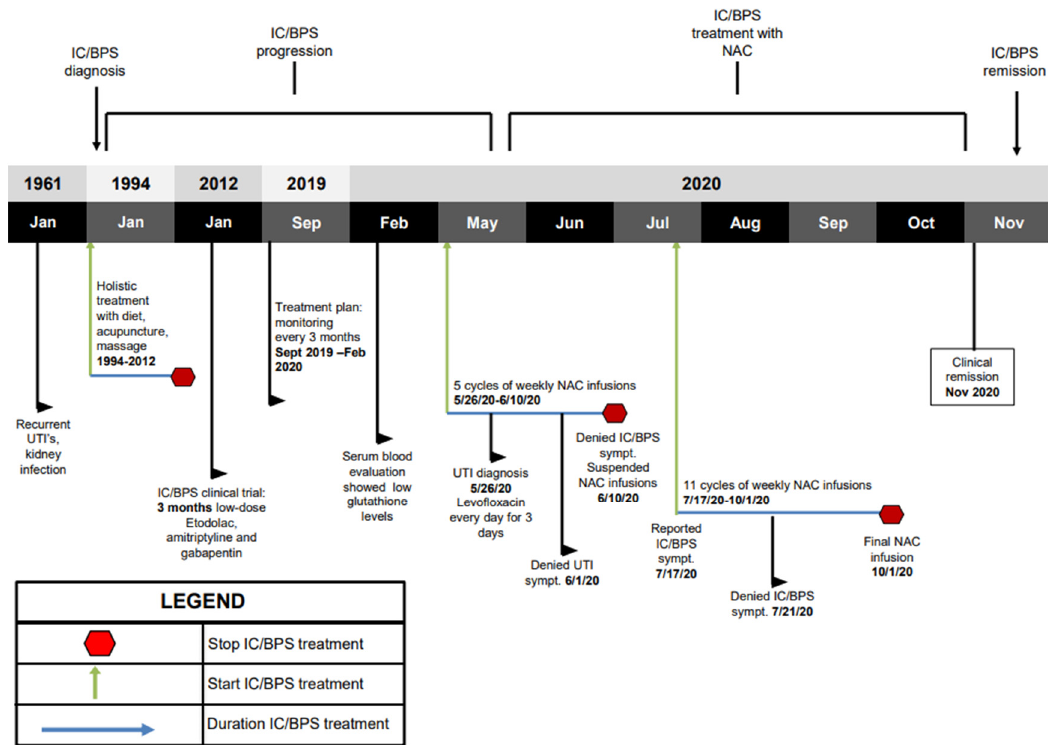
Figure 1. Key timeline information. Green arrows indicate treatment initiation. Blue arrows indicate the duration of treatment. Red octagons indicate when the patient stopped treatment. Beginning in 1994 after IC/BPS diagnosis, holistic treatment was used. In 2012, patient underwent a 3-month IC/BPS clinical trial using low-dose triple therapy. In May 2020, patient began weekly 6000 mg NAC IV infusions. Patient suspended IV infusions in June 2020. Patient resumed NAC IV